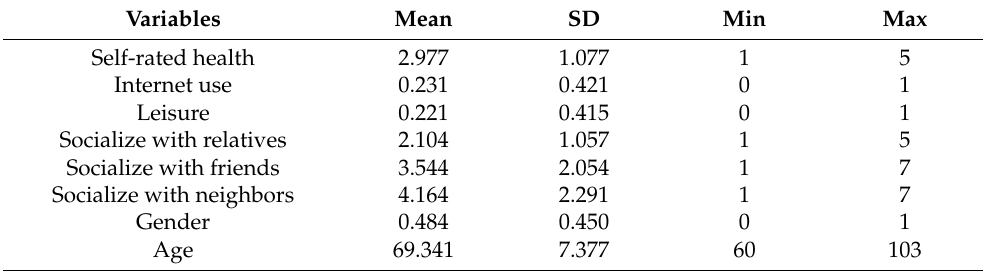
Table 1. Descriptive univariate information for